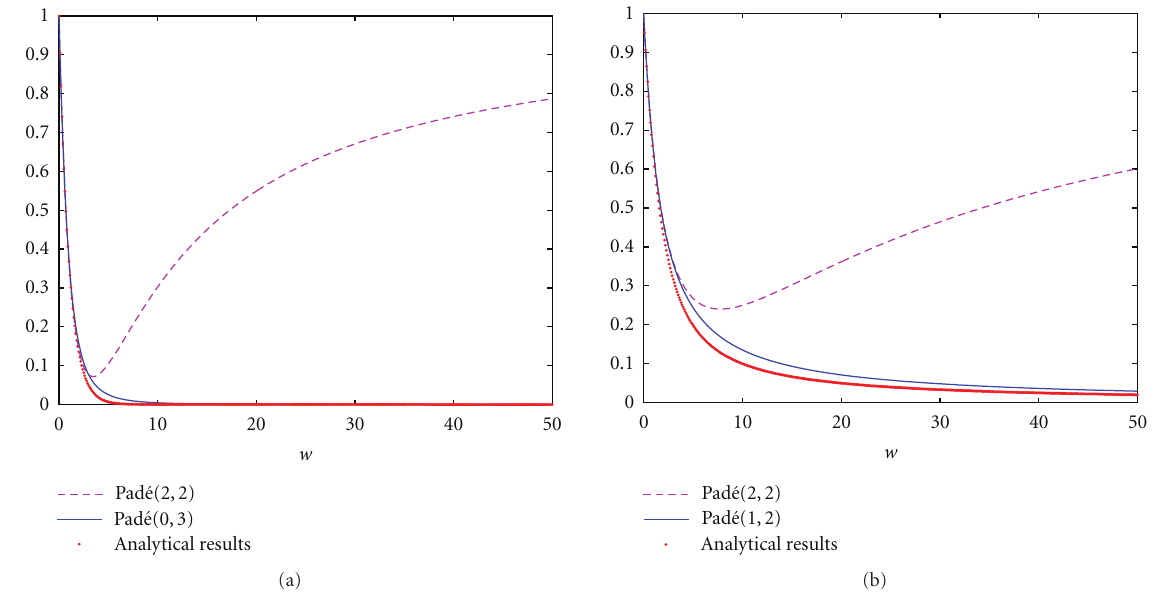
Figure 1: Comparison between two kinds of approximation. (a) For e − w and (b) (1 − e − w ) /w .